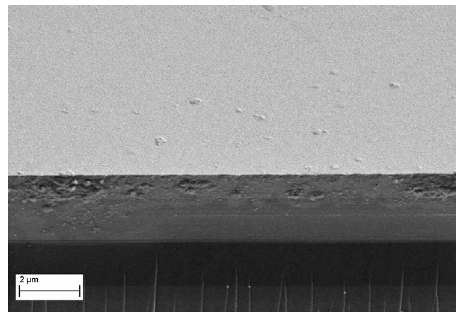
Fig. 1 SEM image of as-deposited film without substrate heating (sample 2). Film/substrate interface is marked on the image.